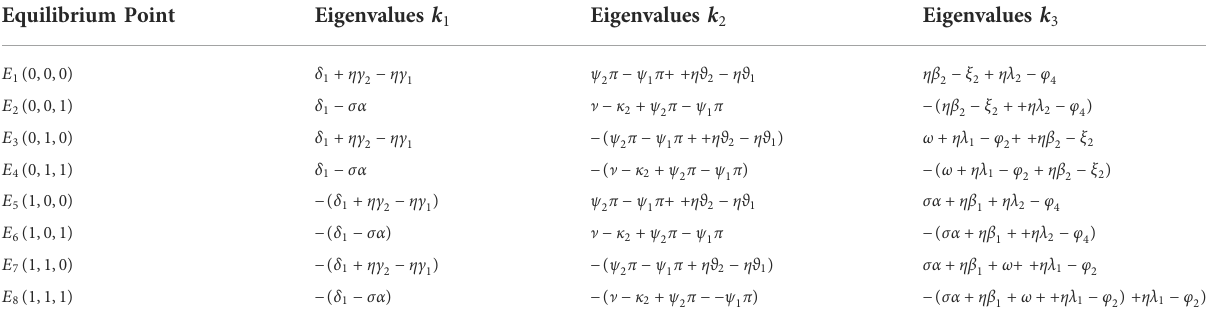
TABLE 2 The eigenvalues of Jacobian matrix.